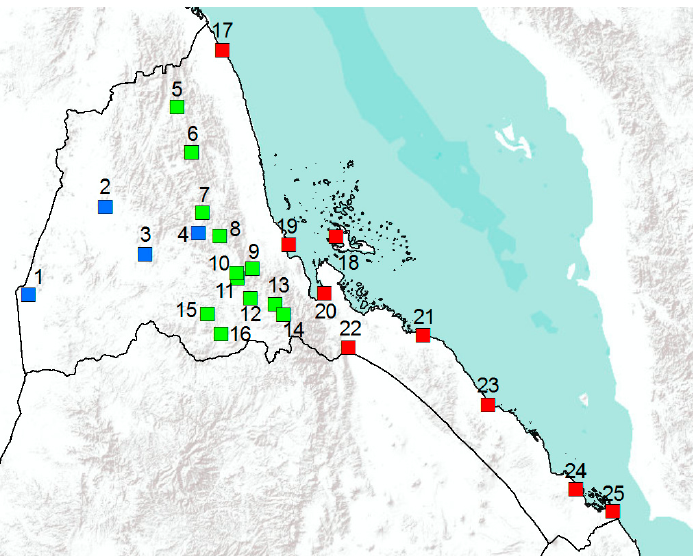
Figure 1. Map with the wind sites studied in this work, marked out. Red markers represent sites in the coastal region, blue markers the western lowland and green markers the central highlands. For site numbering, see Table 1.